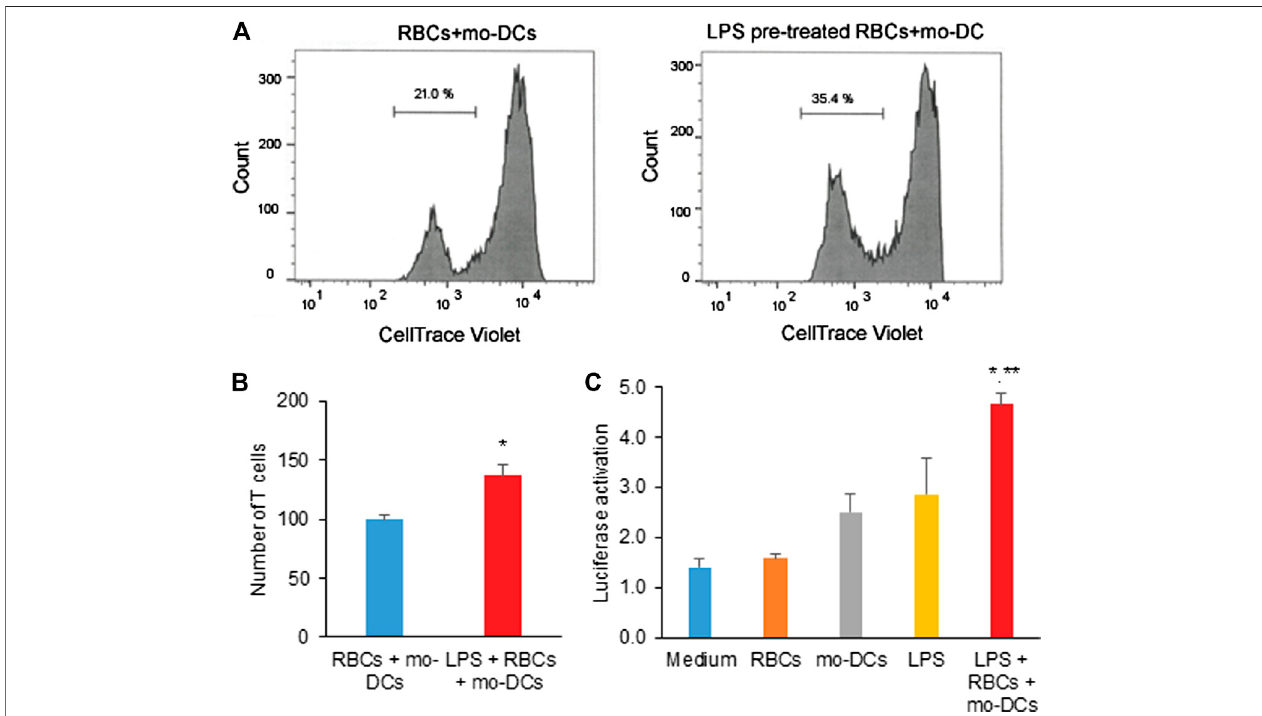
FIGURE 4 | (A) The representative fl ow cytometric histograms by CellTrace Violet staining and the two violet peaks represent new (left) and original (right) generations of CD4 T cells 5 days after being grown in co-cultures of mo-DCs and LPS-pretreated or untreated RBCs. ( B ) The bar graph shows the average number of new generation of CD4 T cells determined from three independent experiments. (C) The effect of LPS pre-treated RBCs co-cultured with mo-DCs on the activation of NF- κ B in naïve T cells by the NF- κ B luciferase assay from 3 independent experiments (** p < 0.01 vs. controls; * p < 0.05 vs. LPS alone).